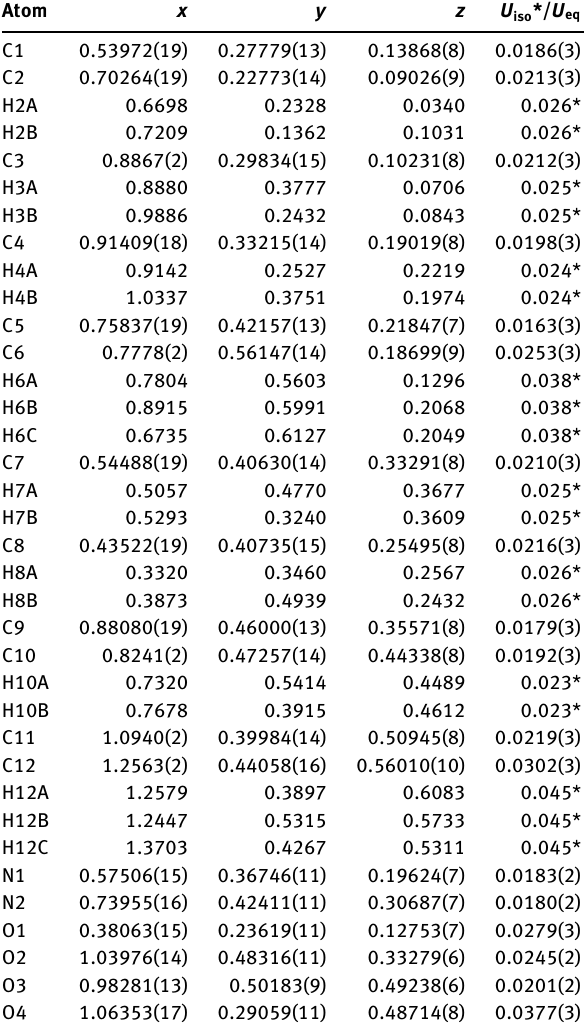
Table 2: Fractional atomic coordinates and isotropic or equivalent isotropic displacement parameters (Å 2 ).